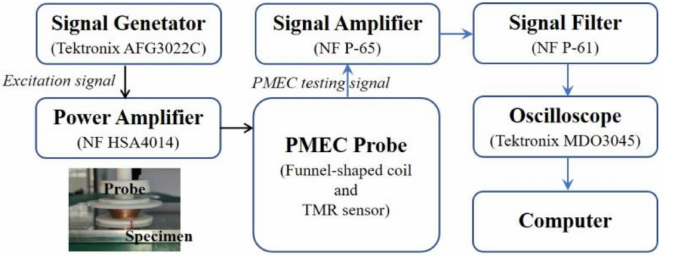
Figure 6. Schematic illustration of the PMEC inspection system (inset: the funnel-shaped probe and testing